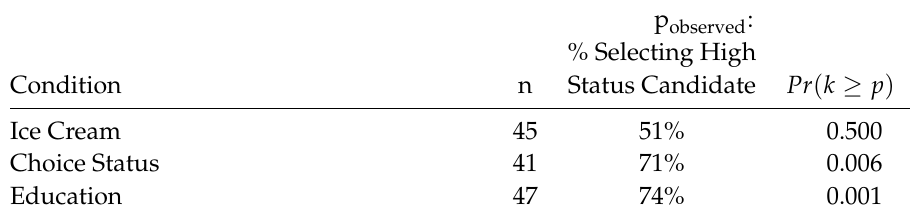
Table 3: Partner Preferences in Study